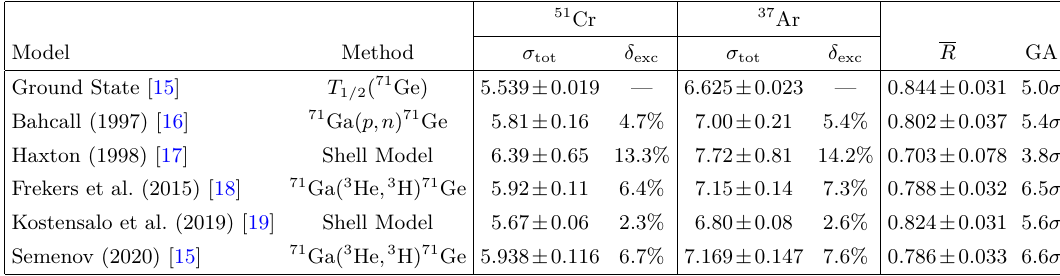
Table 1. ν e + 71 Ga → 71 Ge + e − cross sections in units of 10 − 45 cm 2 and the corresponding relative contributions δ exc of the transitions to the excited states. Also shown are the average ratio R of ob- served and predicted events and the statistical significance of the corresponding Gallium Anomaly.